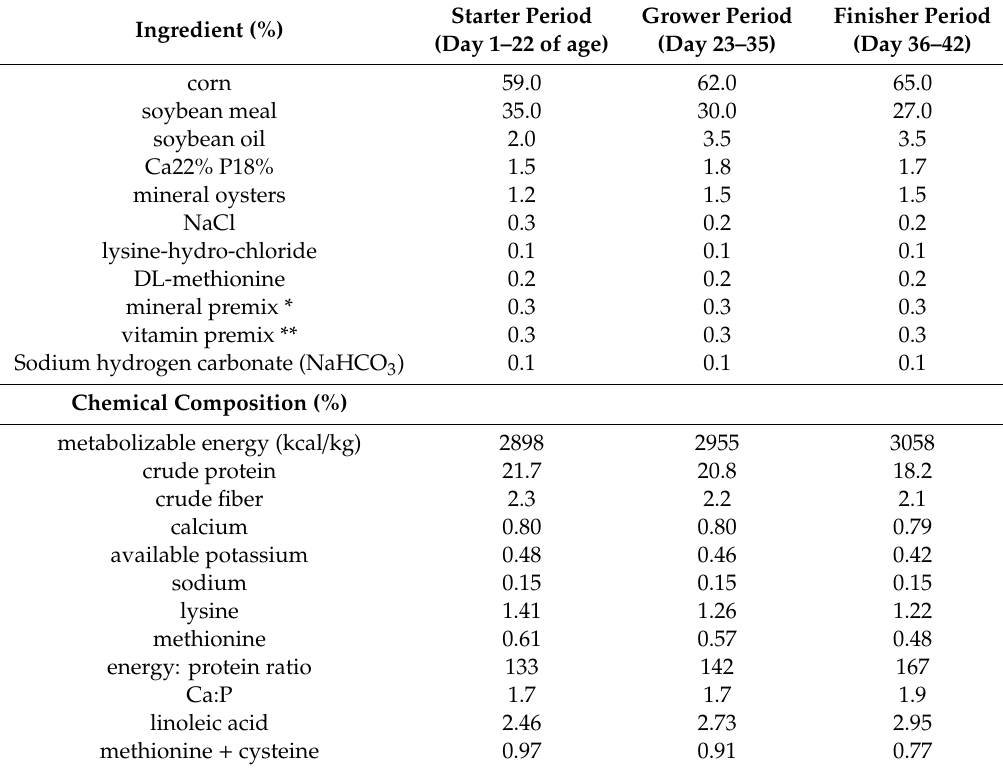
Table 1. Ingredients and chemical compositions of the control diet.